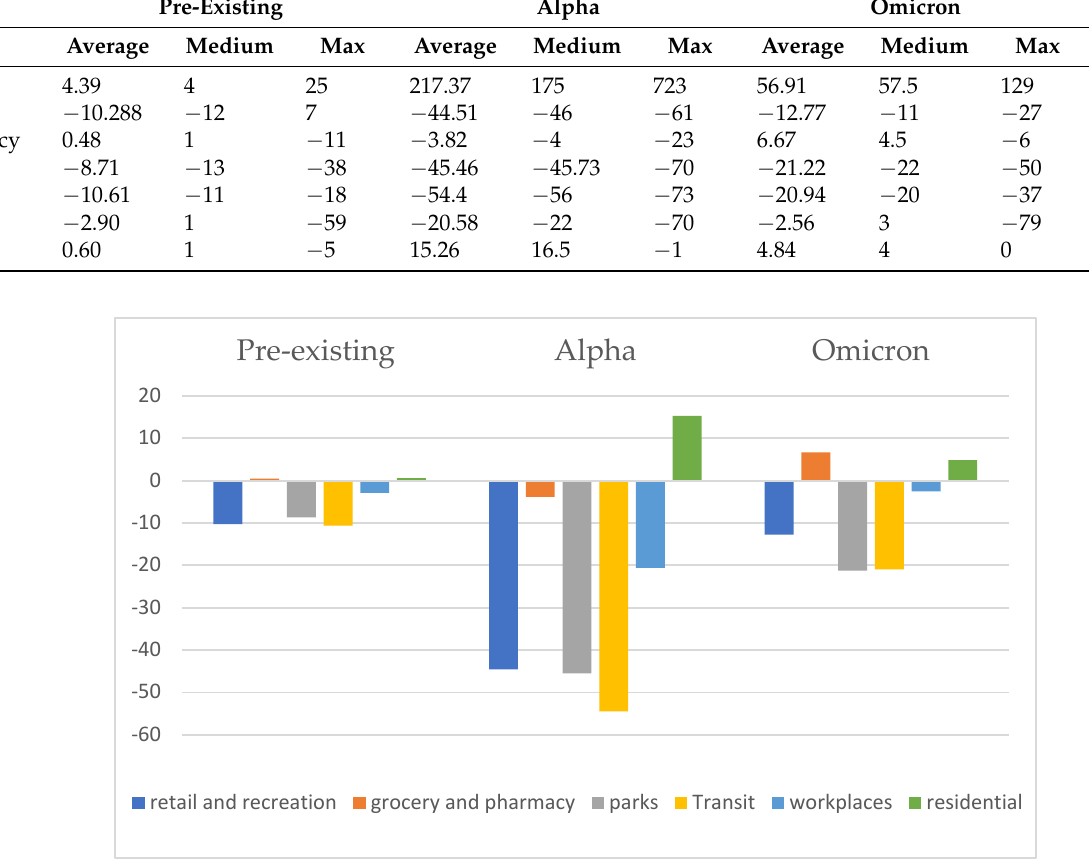
Figure 1. Taiwan population flow change of various places in the community due to COVID-19 epidemic. 3.2. The Relationship between Changes in the Population Visits for Various Locations and the Number of Daily New Confirmed Cases Per Million People (7-Day Rolling Average)